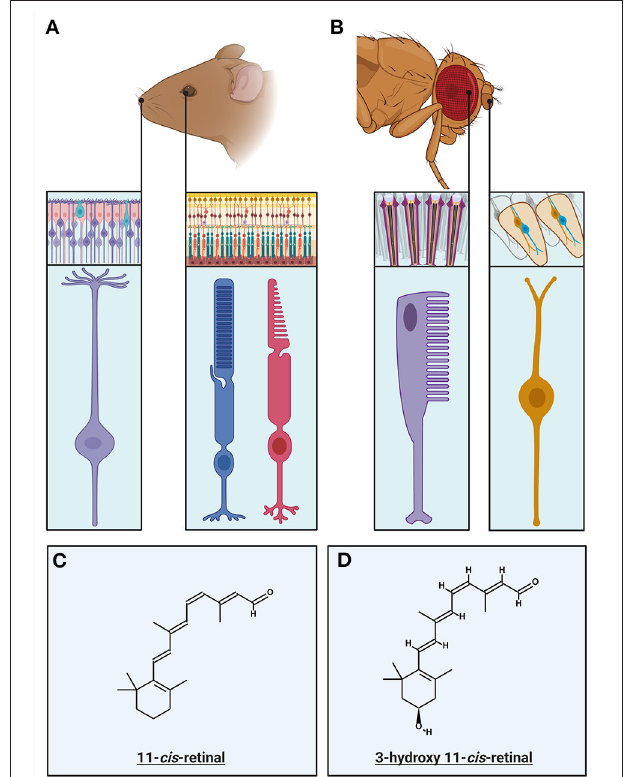
FIGURE 1 | Primary Sensory Neurons of the invertebrate and vertebrate visual and olfactory sensory systems: (A) The primary sensory neurons in the vertebrate olfactory and visual systems and their respective circuitry. Rods (blue) and cones (magenta) mediate vision at different light intensities. Rods mediate low light vision and having specializations enabling this, detailed within this review. Cones mediate daylight color vision and have specific specializations that mediate this. The olfactory sensory neurons (purple) have multiple cilia protruding from the end of the neuron into the olfactory lumen, in which the olfactory transduction machinery, including olfactory receptors, are localized. (B) The primary sensory neurons in the invertebrate ( Drosophila ) olfactory and visual systems, within their respective circuitry. The invertebrate ommatidium is the structure in which invertebrate photoreceptors (rhabdomeres) are coupled with the support and pigment cells. The rhabdomere (purple) is primary sensory neuron in which the visual transduction machinery is localized within the villi. The olfactory sensory neurons (OSNs) are located within sensory hairs, sensilla. OSNs (orange) project dendrites into the sensillum, with the olfactory receptors expressed on the surface. (C) The chemical structure of the chromophore responsible for vertebrate visual transduction, 11- cis -retinal. (D) The chemical structure of the chromophore present in Microvillar photoreceptors, 3-hydroxy-11- cis -retinal.